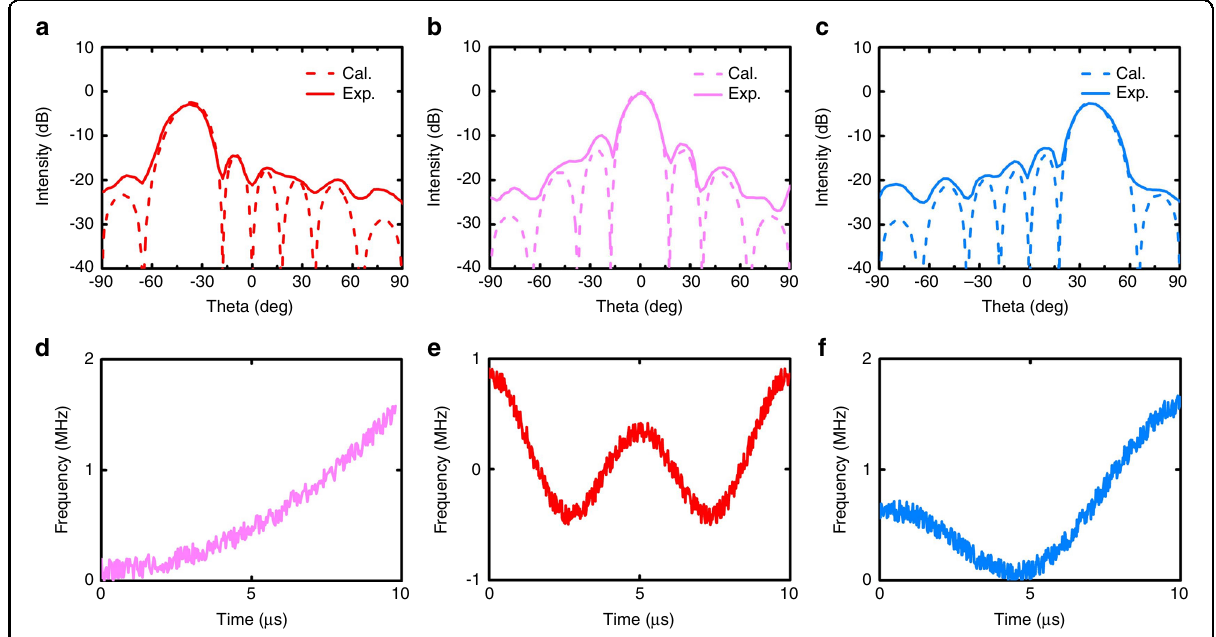
Fig. 6 Measured results of the polynomial, double sinusoidal, and S-shaped FMCWs. a – c The calculated and measured scattering patterns in the space domain for the cases of polynomial, double sinusoidal, and S-shaped FMCWs. d – f The corresponding time-frequency curves for the waveforms in a –